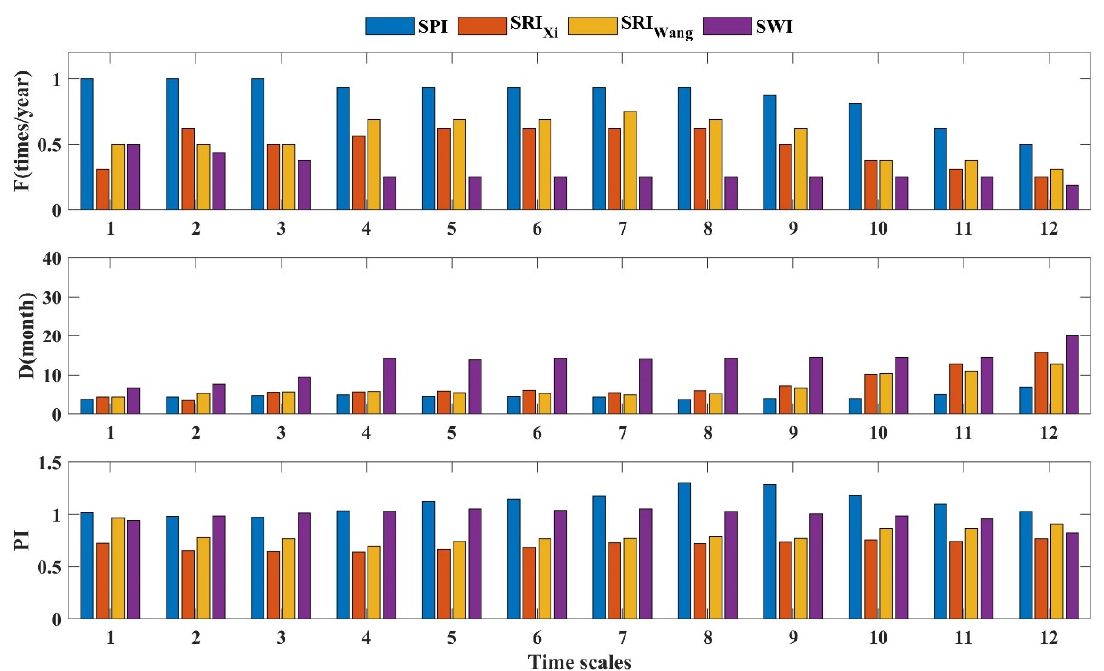
Figure 8. Drought characteristics of the SPI, SRI Xi , SRI Wang , and SWI for different timescales before a changing environment (PI denotes the absolute values.).